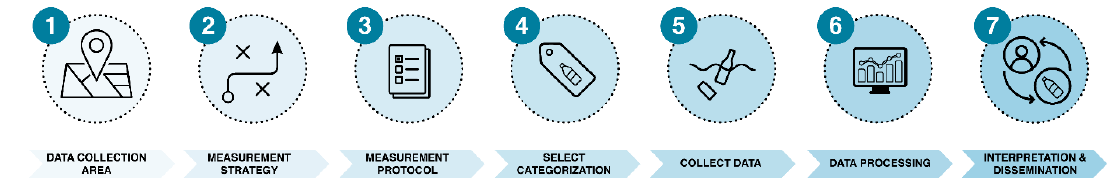
Figure 2. The seven steps for plastic hotspot mapping in urban water systems.